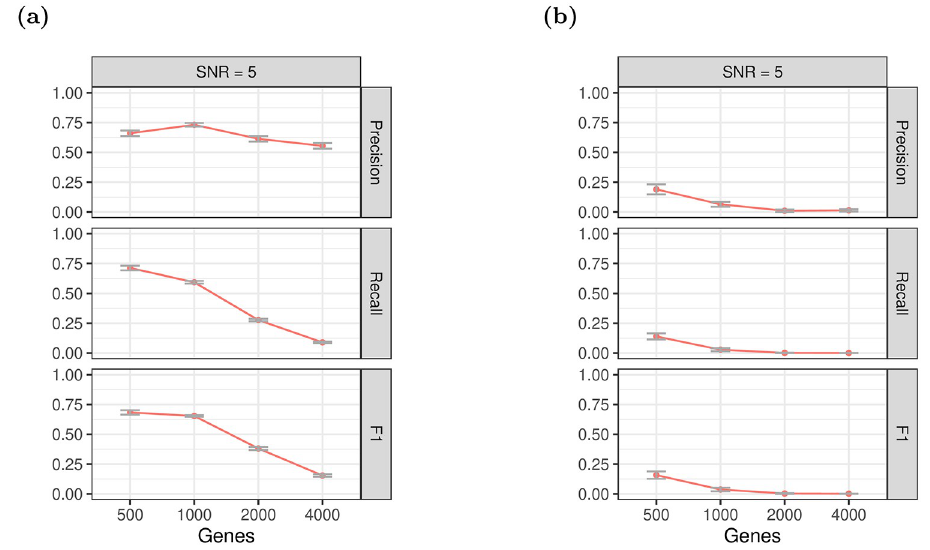
Fig 10. Performance on increasingly large data sets. (a) glinternet and (b) xyz .